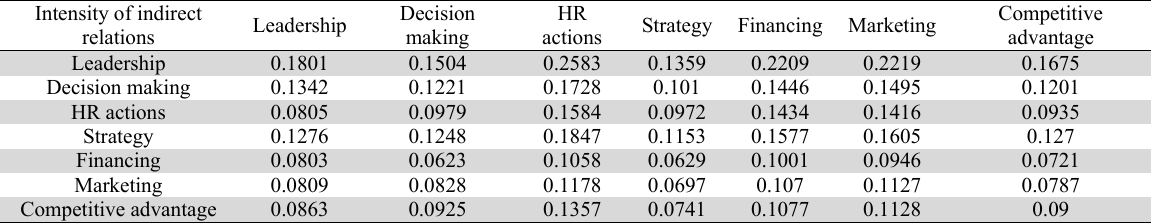
Step 5: Matrix of the intensity of indirect relations Intensity of indirect Decision Leadership relations making